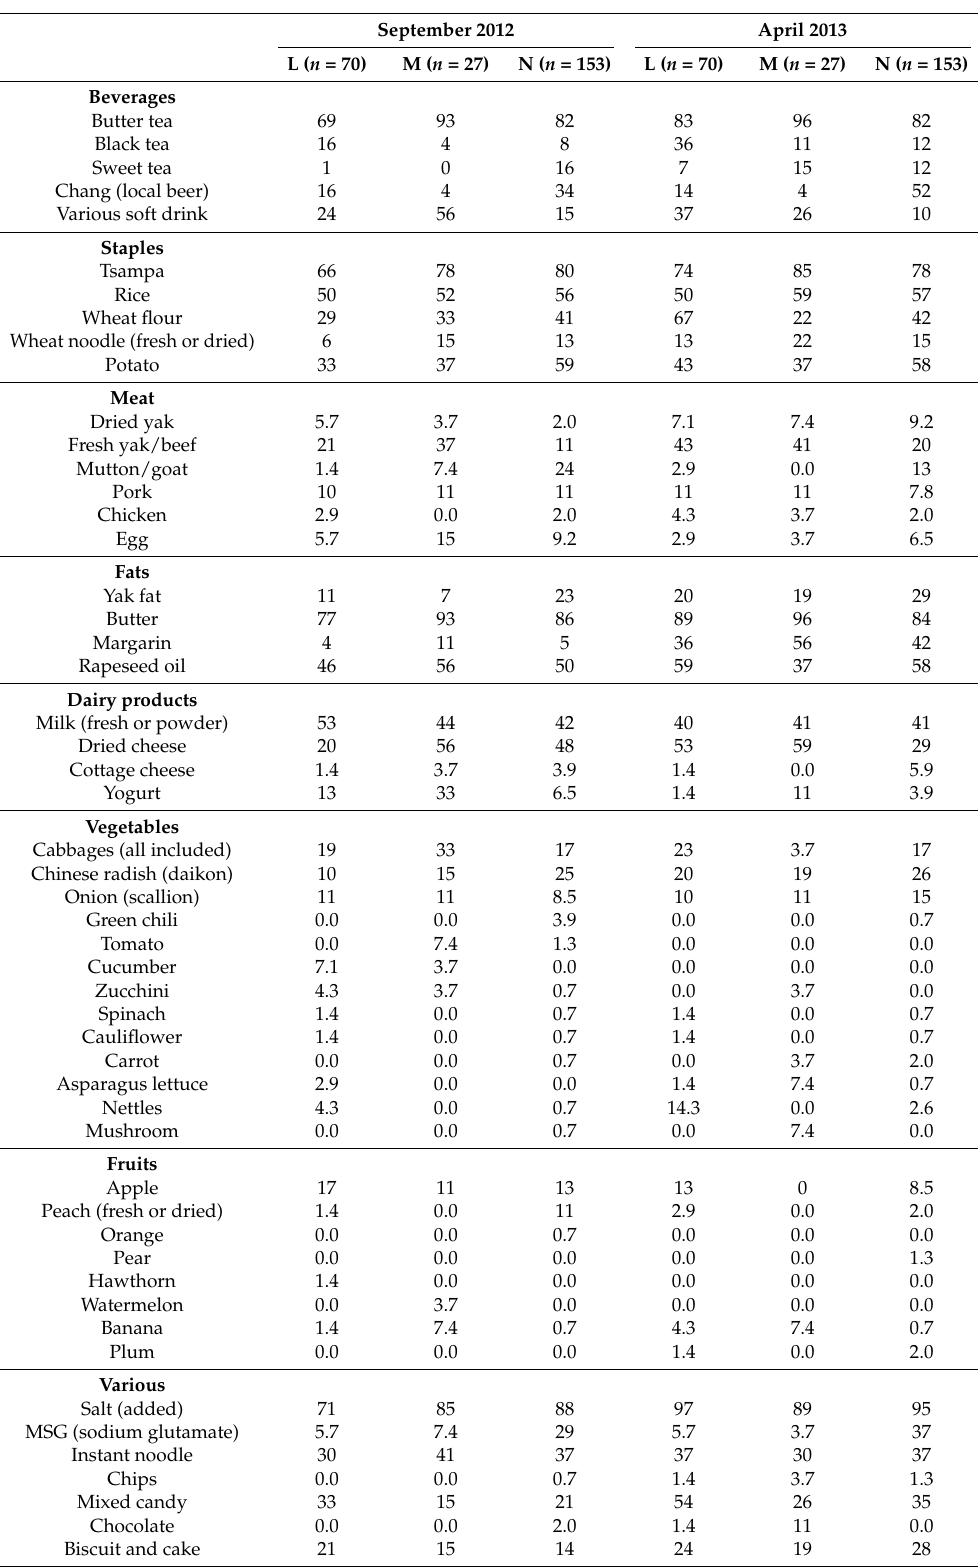
Table 1. Relative consumption (%) of different foodstuffs by young rural Tibetan children according to the factors county and